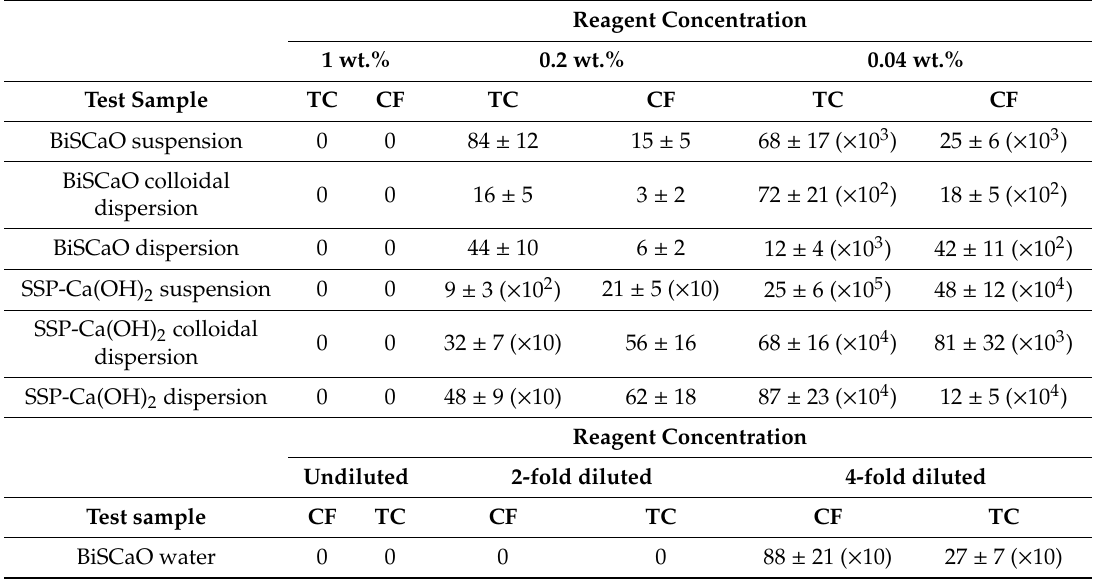
Table 2. Decrease of total viable bacterial cells (TC) and coliform bacteria (CF) by various BiSCaO-based disinfectants ( n = 3). Reagent Concentration 1 wt.% 0.2